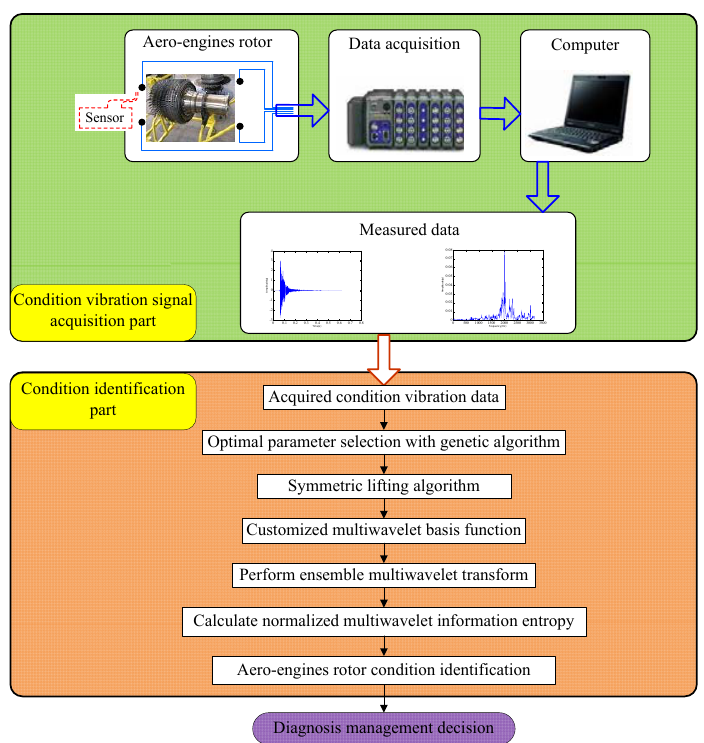
Figure 4. The flow chart of the proposed